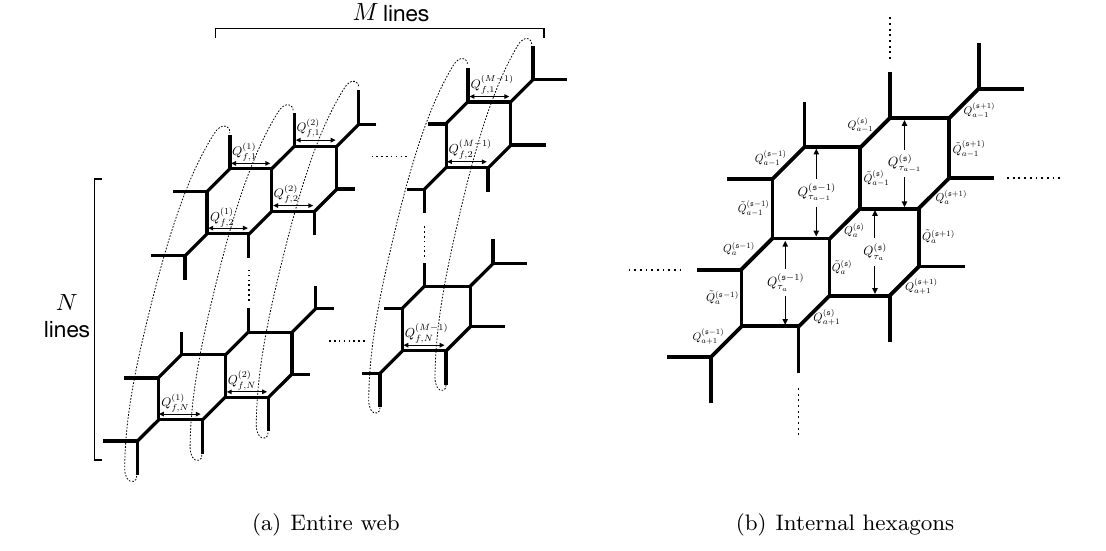
Figure 4 . The web diagram with M vertical and N horizontal